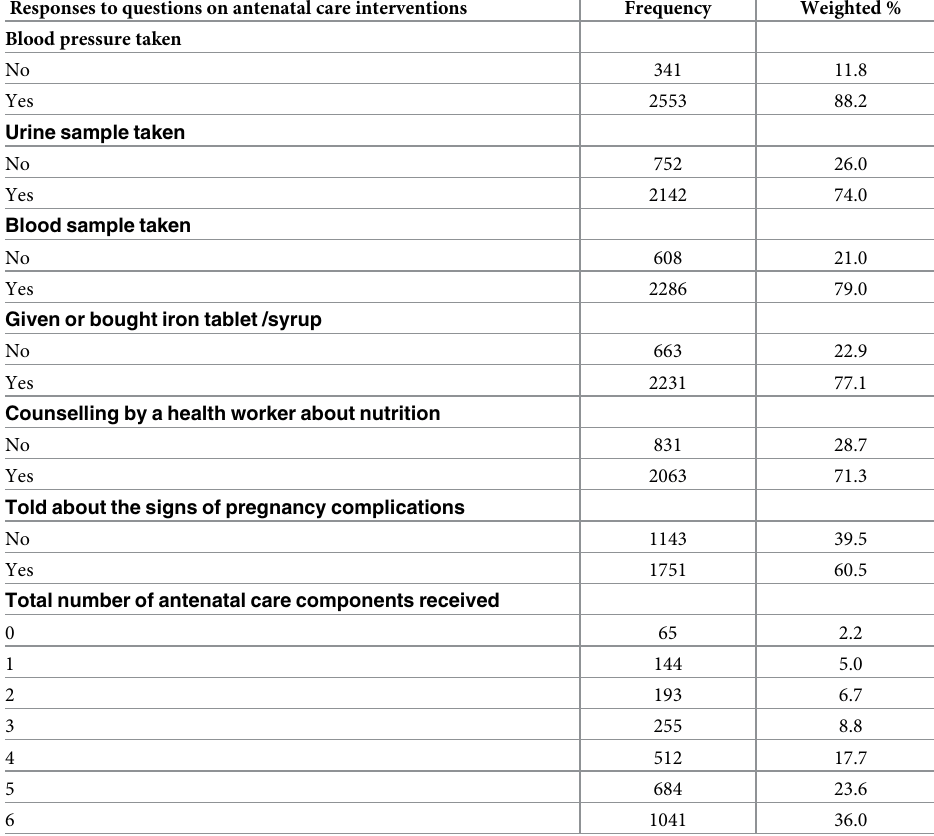
Table 2. Distribution of the components of prenatal care received by women before delivery in this study (N =